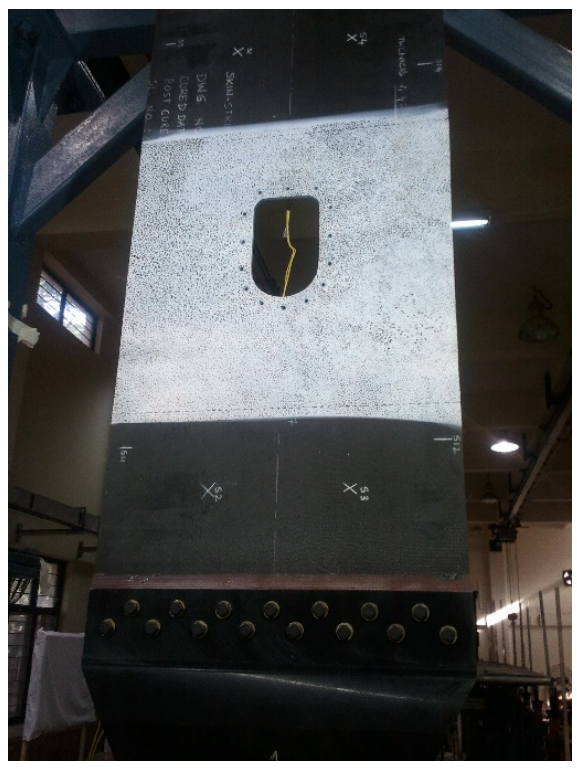
Figure 16. Speckling on panel skin for DIC.